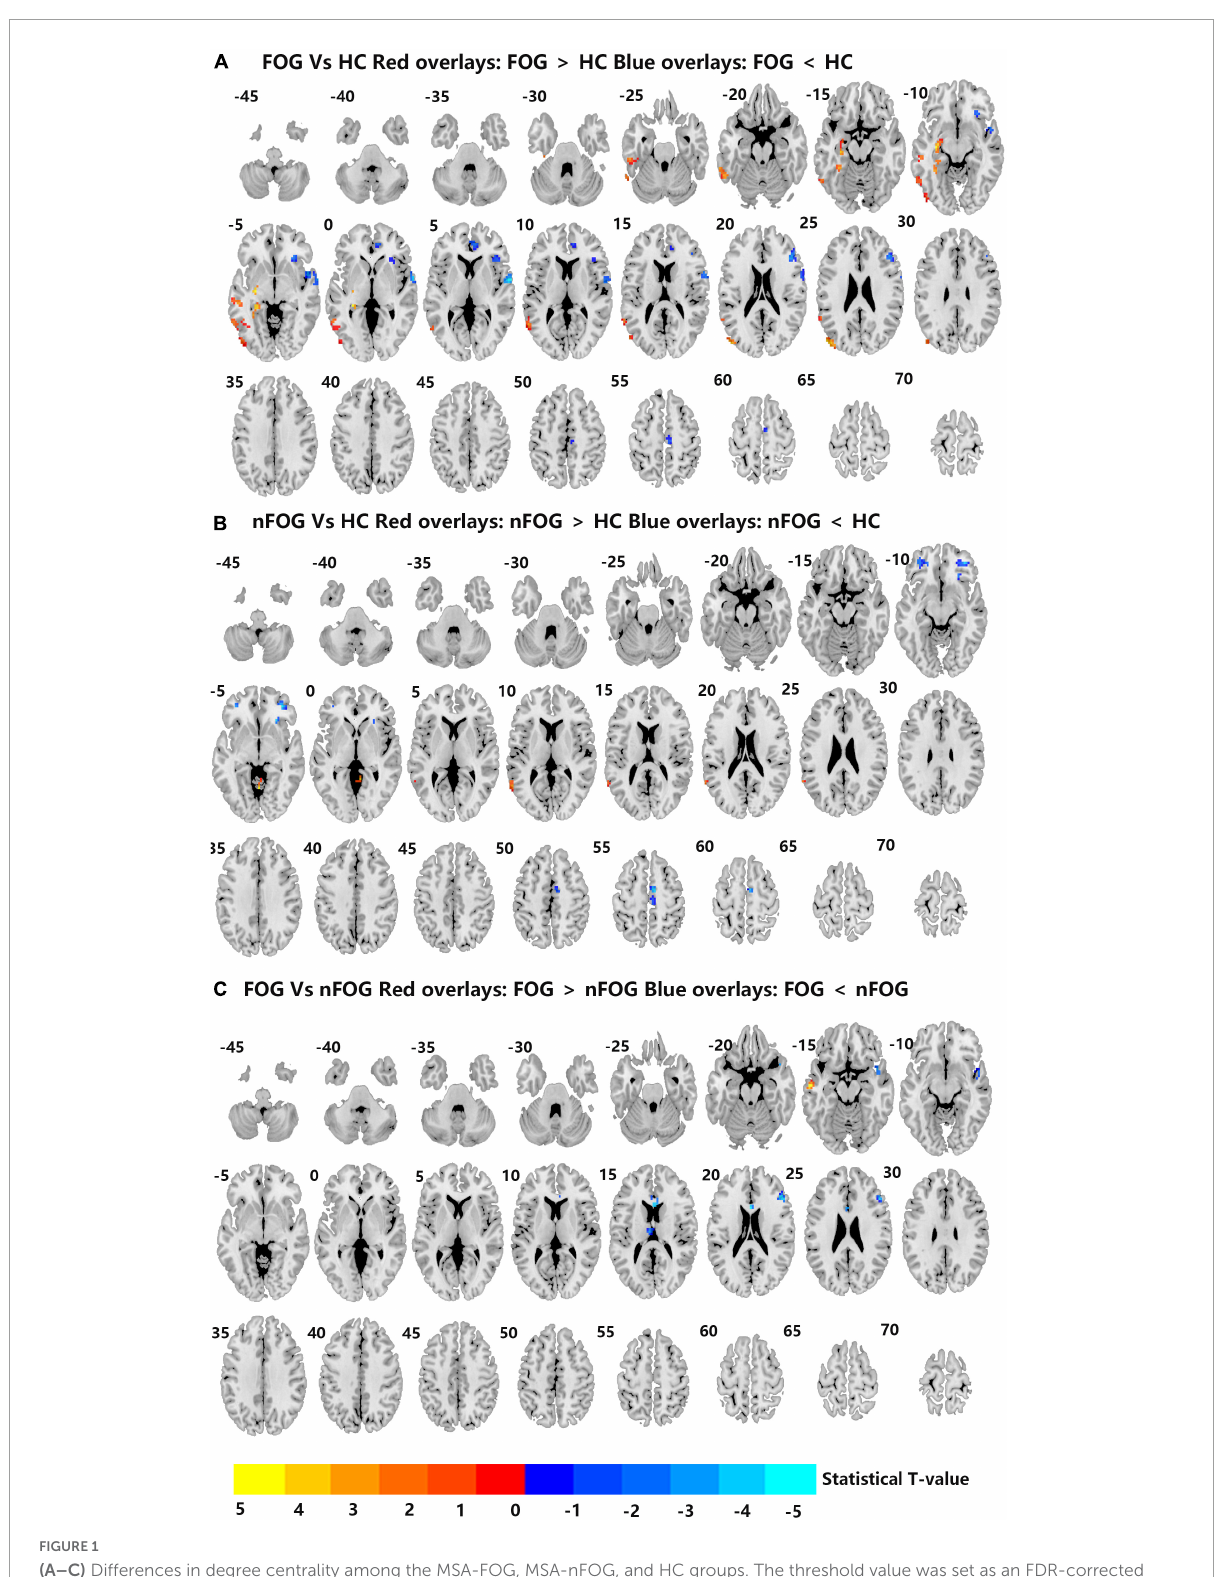
FIGURE1 (A–C) Differences in degree centrality among the MSA-FOG, MSA-nFOG, and HC groups. The threshold value was set as an FDR-corrected p < 0.05. MSA-FOG, multiple system atrophy with freezing of gait; MSA-nFOG, multiple system atrophy without freezing of gait symptoms; HCs, healthy